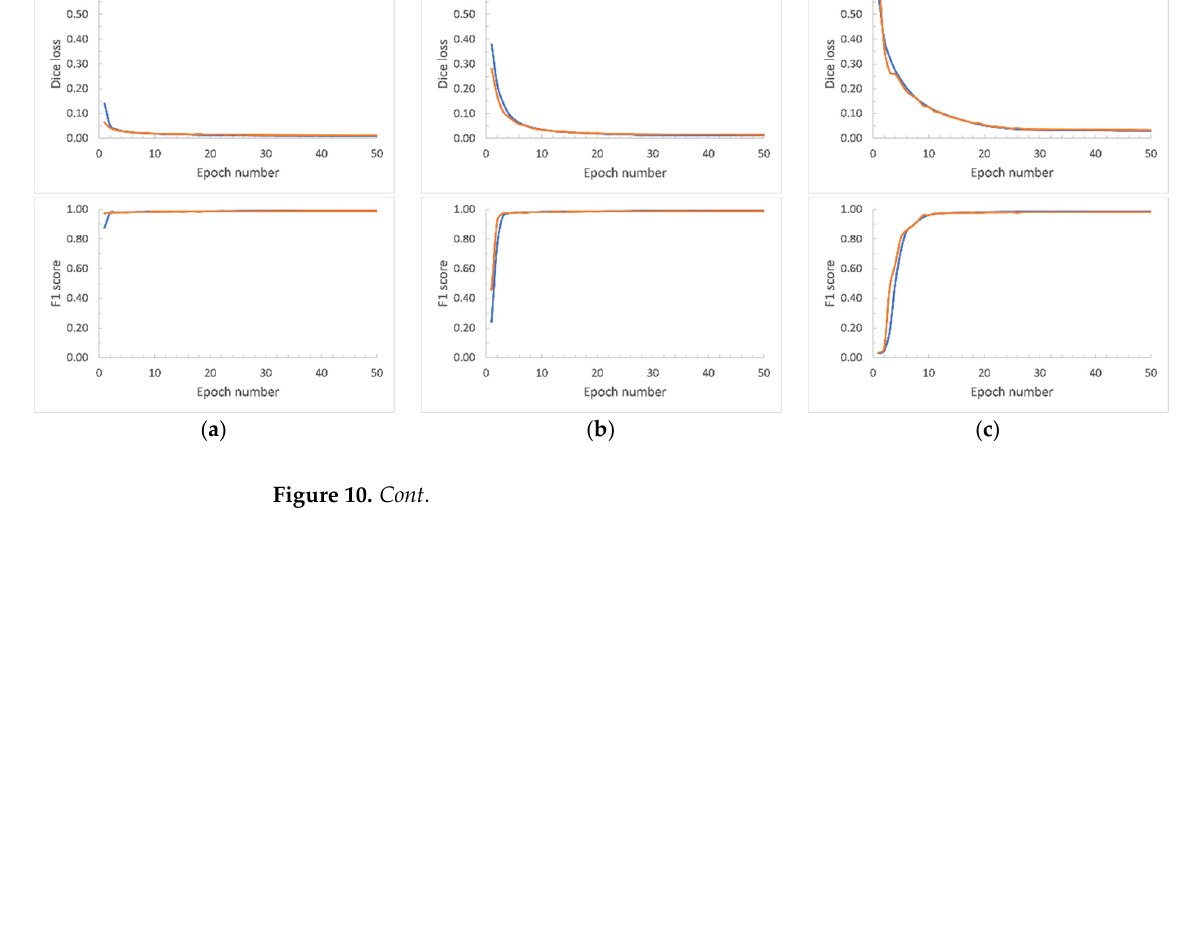
Figure 9. Training (blue line) and validation (orange line) Dice loss curves based on the hand- annotated data from Banks Island. Array sizes are shown in pixels. ( a ) Image tile size: 2048 × 2048, Network input size: 1024 × 1024. ( b ) Image tile size: 2048 × 2048. Network input size: 512 × 512. ( c ) Image tile size: 2048 × 2048. Network input size: 256 × 256. ( d ) Image tile size 1024 × 1024.